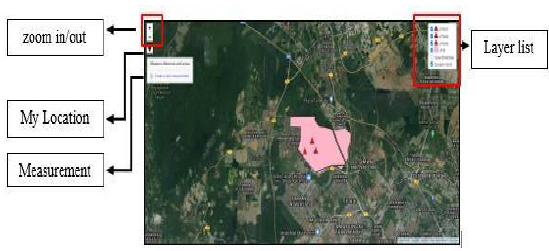
Figure 13. Overview of Maps of Web-Based GIS for Smart Water Network monitoring in UTM.